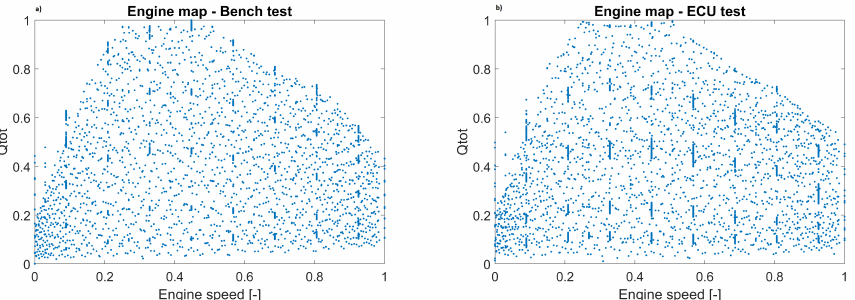
Figure 2. Engine operating points in stationary conditions through ( a ) test bench and ( b ) ECU acquisition